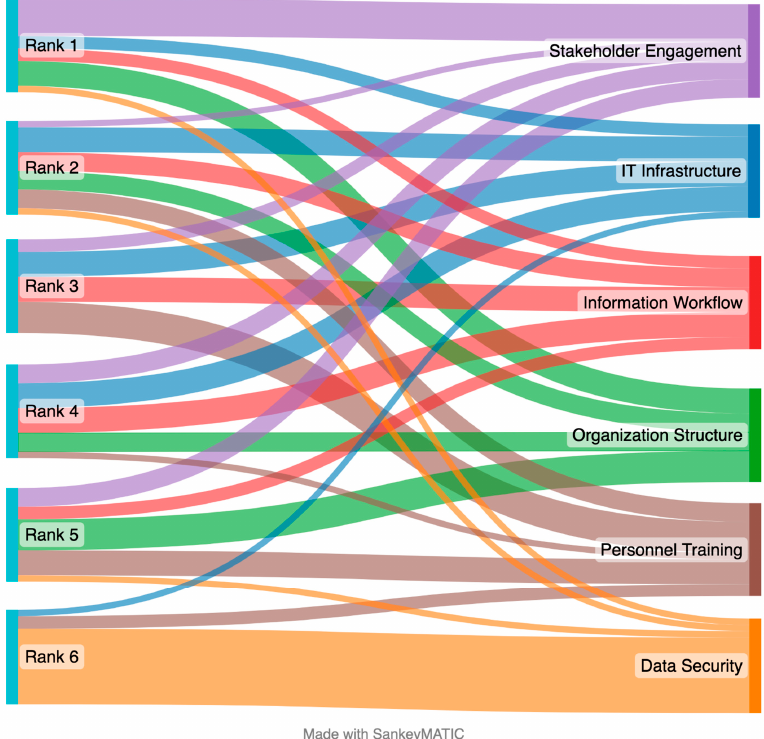
Figure 4. Ranking of six technology implementation factors for workshop validation data using the Sankey diagram ( n = 15). Table 6. Weight of People, Process, and Technology from the survey and workshop validation.